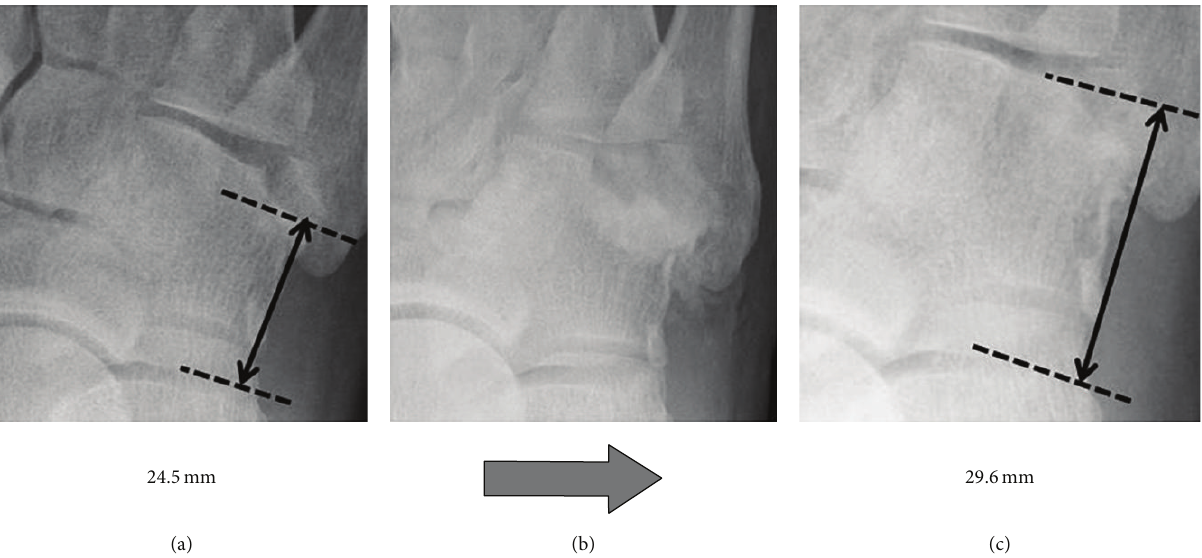
Figure 7: Lateral column length: (a) prior to surgery; (b) immediately after surgery; (c) 6 months after surgery.